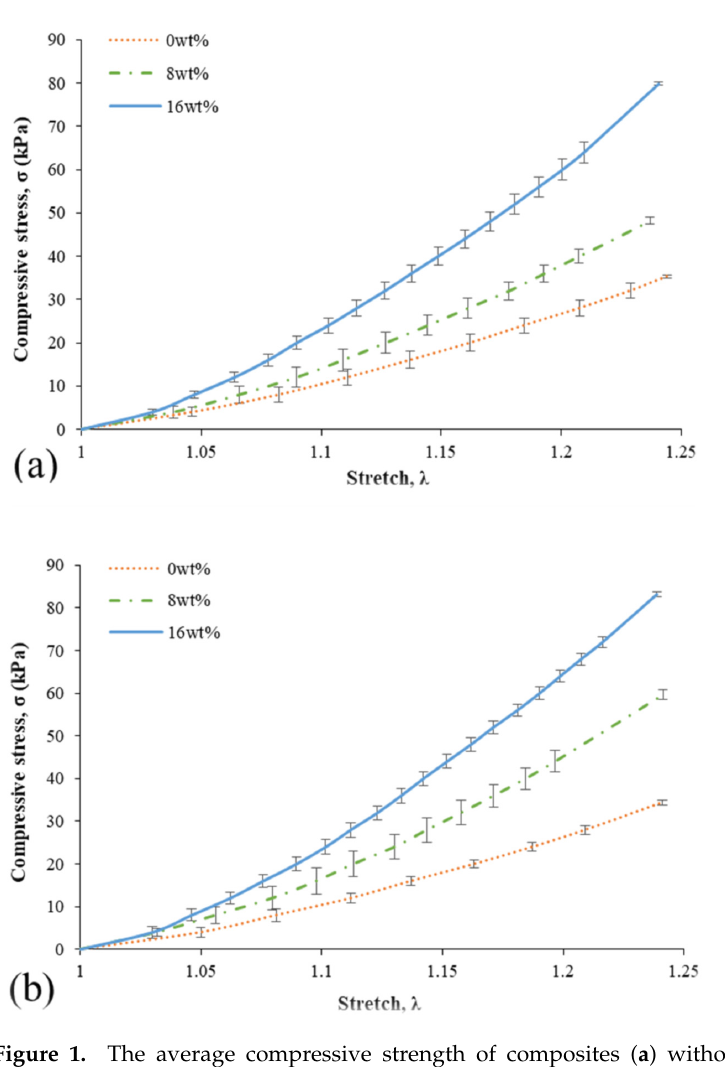
Figure 1. The average compressive strength of composites ( a ) without being immersed and ( b ) immersed in seawater.